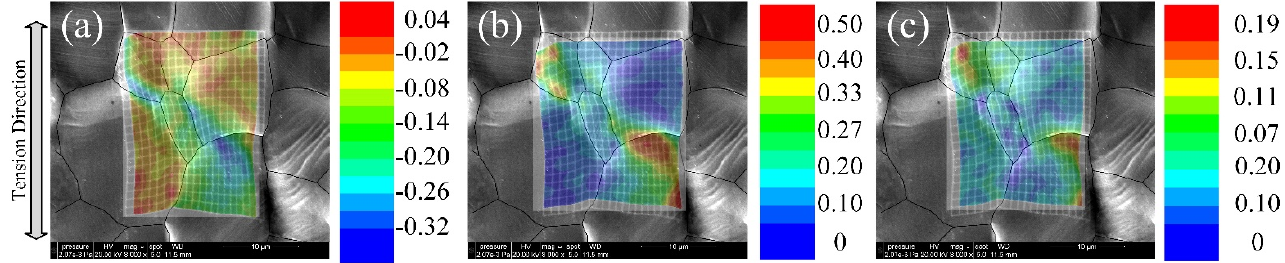
Figure 4. DIC analysis of ( a ) ε yy , ( b ) ε xx and ( c ) γ yx at the strain of 0.15 (x-axis is parallel to the tension direction).